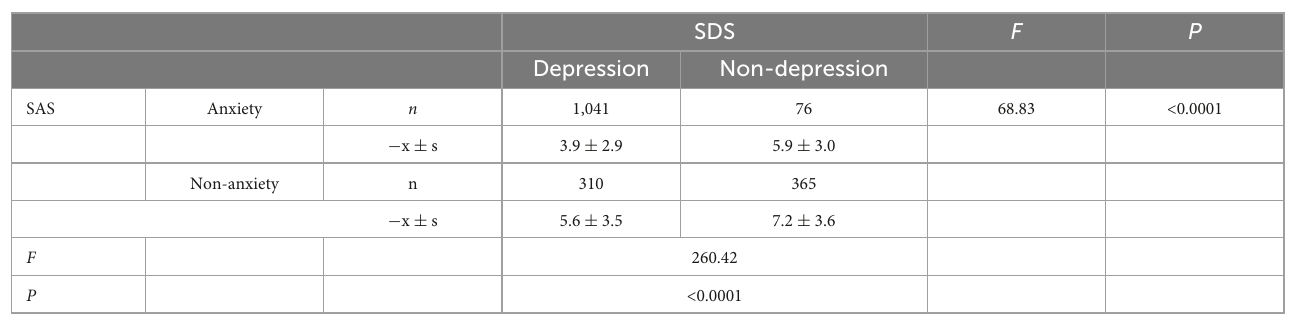
TABLE 2 Effects of depression and anxiety on fatigue score (FS-14).